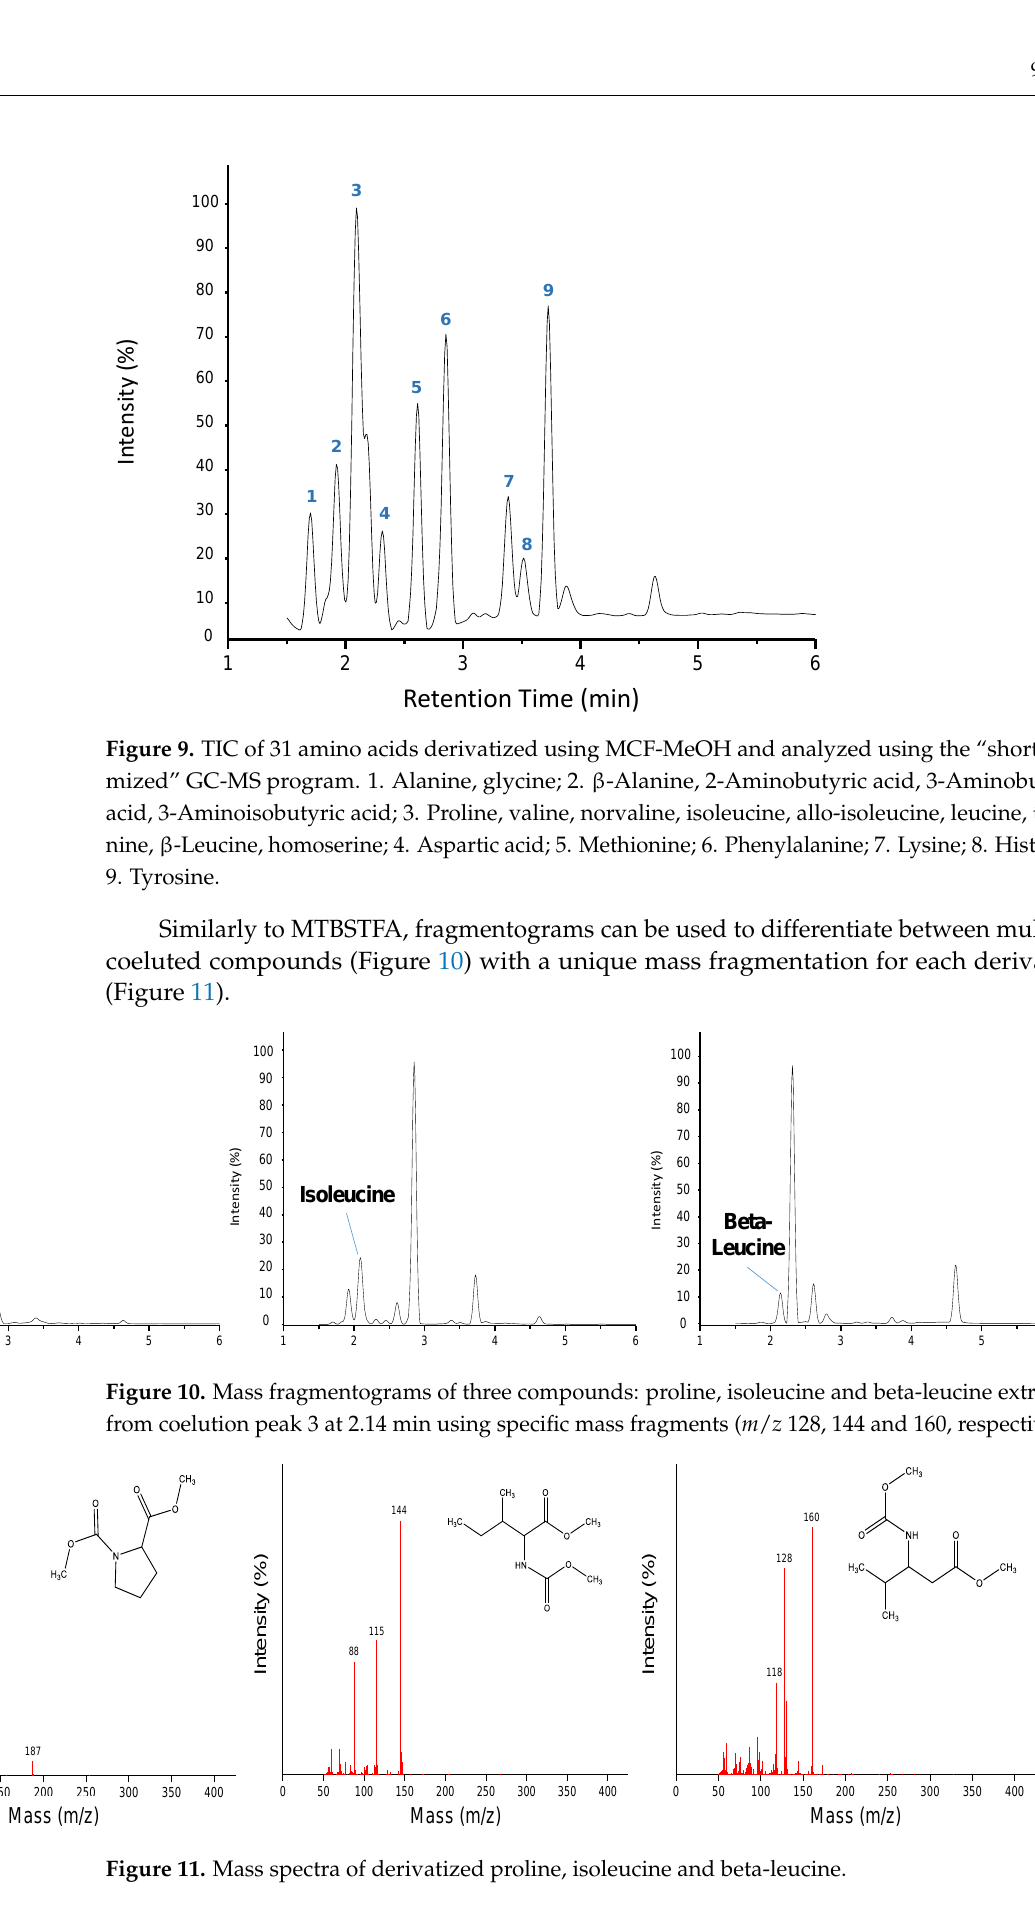
Figure 11. Mass spectra of derivatized proline, isoleucine and beta-leucine.